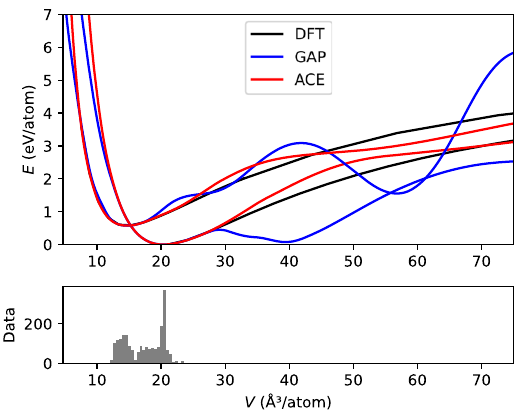
Fig. 7 Extrapolation for large volumes. Comparison of ACE and GAP to DFT for the energy-volume curves for diamond and bcc structures of Si. The lower panel shows the volume distribution of the reference data.